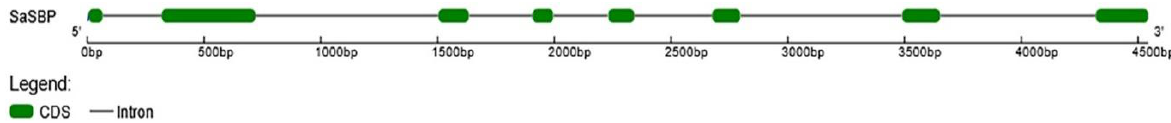
Figure 4. Structures of SaSBP gene.